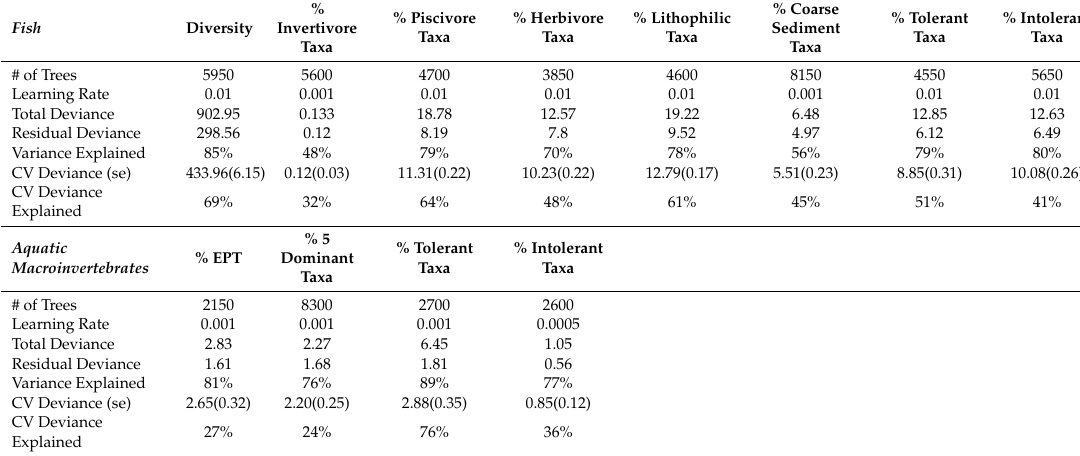
Table 3. Boosted regression tree result for fish (richness, diversity, % invertivore taxa, % piscivore taxa, % herbivore taxa, % lithophilic taxa, % taxa preferring coarse substrate, % tolerant taxa, and % intolerant taxa) and aquatic macroinvertebrates (% EPT taxa, % 5 dominant taxa, % tolerant taxa, and % intolerant